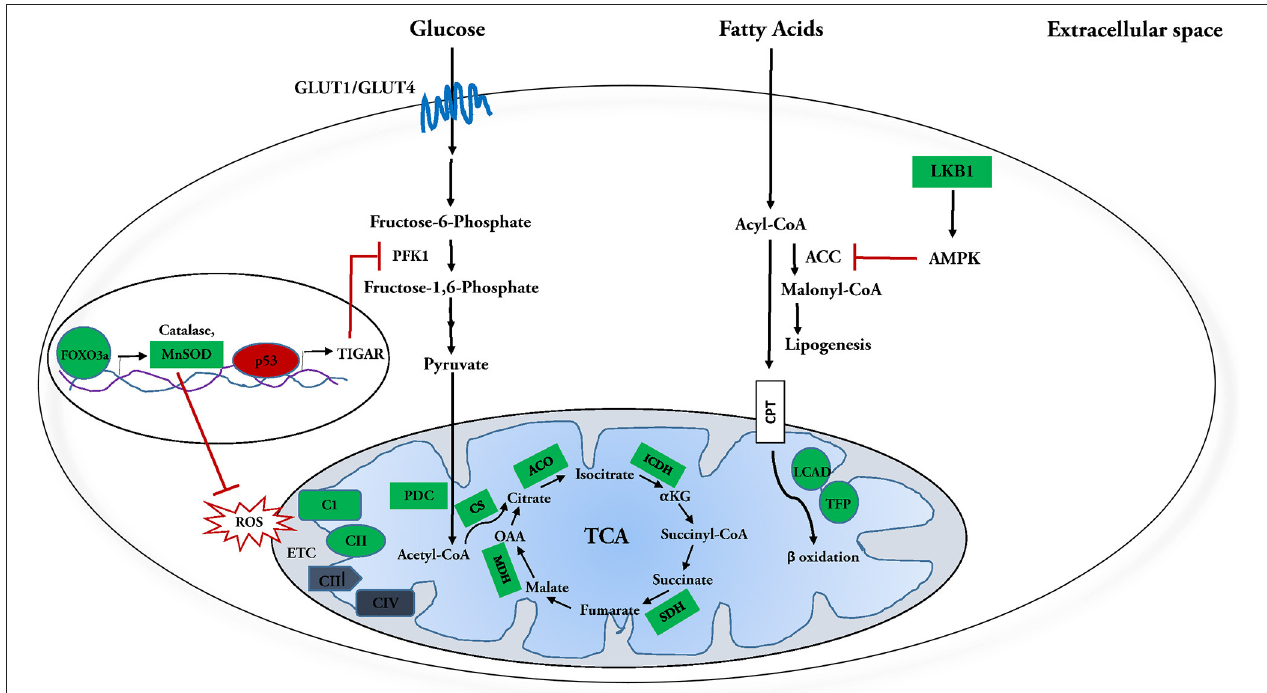
FIGURE 1 | Molecular targets of SIRT3 in glucose and fatty acid metabolism. SIRT3 and fatty acid metabolism: SIRT3 deacetylates and activates enzymes involved in fatty acid oxidation, including long chain aycl-CoA dehydrogenase (LCAD) and trifunctional mitochondrial protein (TFP). Meanwhile it inhibits fatty acid synthesis by deacetylating and activating its inhibitor, LKB1, which in turn activates AMPK. AMPK further phosphorylates and inhibits Acetyl-CoA carboxylase (ACC) and Malonyl-CoA decarboxylase (MCD), reducing synthesis of malonyl-CoA, a negative regulator of fatty acid oxidation. In this manner, SIRT3 regulation culminates in enhanced fatty acid catabolism. SIRT3 and glucose metabolism: SIRT3 attenuates-activation of FOXO3a, which in turn transcriptionally upregulates ROS detoxification enzymes manganese dependent super oxide dismutase (MnSOD) and catalase. SIRT3 also directly interacts with and activates MnSOD. Attenuation of ROS inhibits HIF-1 α from upregulating glycolytic genes during normoxia. SIRT3 enhances phosphofructokinase 1 (PFK 1) activity and subsequently upregulates glycolysis by increasing PFKFB3 activity via deacetylation-inactivation of p53 and subsequent suppression of its downstream target TIGAR. SIRT3 further increases glucose oxidation by activating pyruvate dehydrogenase complex (PDC) and targeting the enzymes involved in the tricarboxylic acid (TCA) cycle. SIRT3 mediated deacetylation of complex I subunit, NDUFA9 and succinate dehydrogenase (SDH) is necessary for efficient oxidative phosphorylation. In this manner, SIRT3 regulation culminates in enhanced utilization of glucose. Positively regulated SIRT3 molecular targets are indicated in green; negatively regulated targets are indicated in